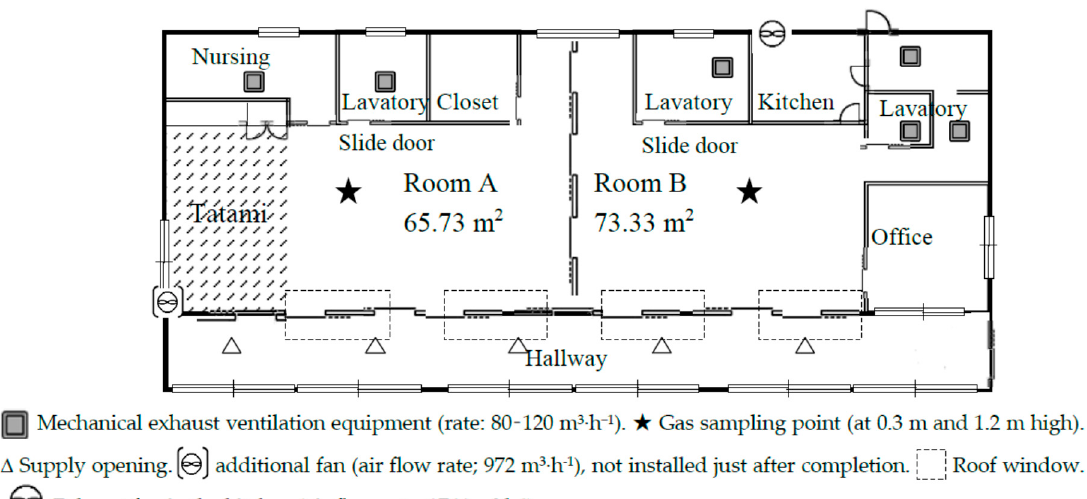
Figure 1. Floor plan of the new daycare center. The additional fan was not installed just after completion, and installed at the tatami room and operated at the measurements after 3 months.